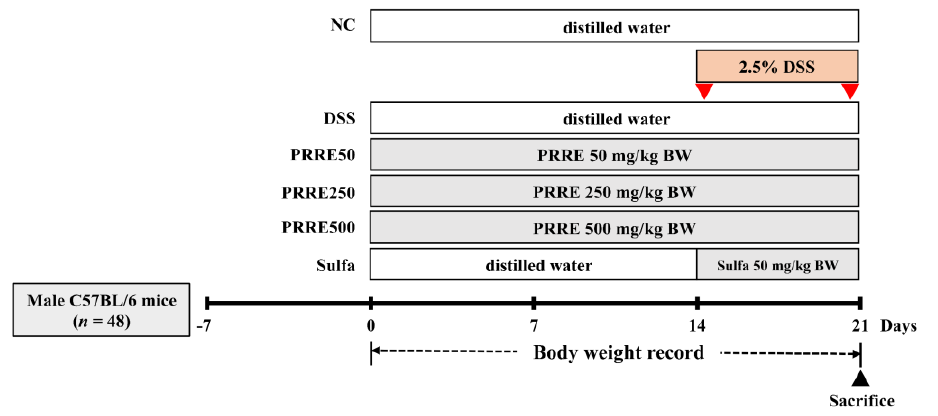
Figure 1. Overview of the experimental design for investigating the anti − colitis effect of PRRE against DSS − induced colitis in mice. DSS, dextran sulfate sodium; PRRE, proanthocyanidins rich red rice extract; sulfa, sulfasalazine.